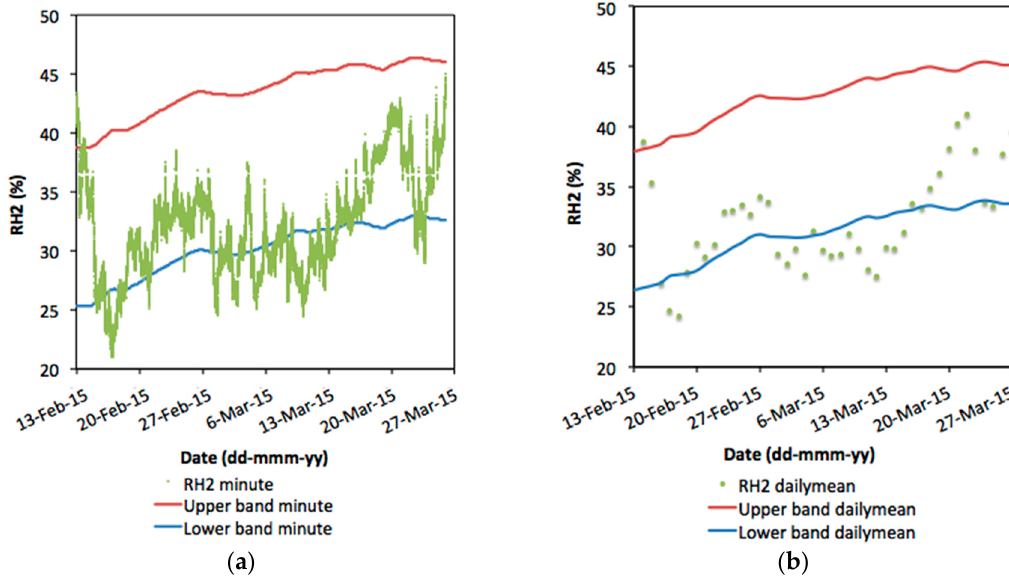
Figure 6. RH data of the 42 days tested (from 14 February 2016 to 26 March 2016) and associated limit bands of one-minute sampling ( a ) and of daily means calculated with the sampling every hour ( b ). The large difference in the amount of data employed in the evaluation is shown clearly.